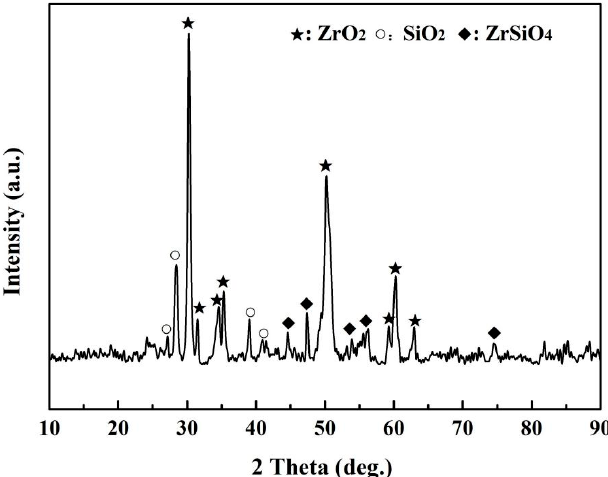
Figure 12. The XRD result of the sample with 30 wt.% ZrSi 2 in the ZrSi 2 -SiC outer coating after 198 h oxidation at 1500 °C .